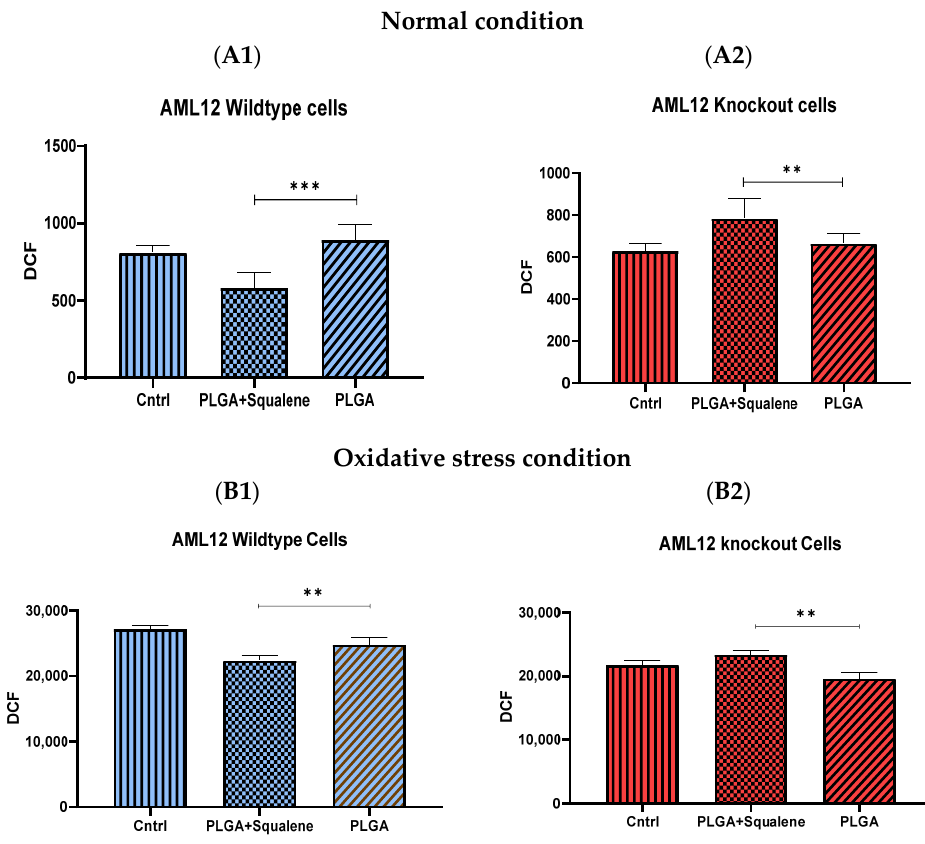
Figure 4. Assessment of ROS production in normal mouse AML12 cells cell line (AML12 wild-type (WT)) and TXNDC5-deficient AML12 cells (AML12 knockout (KO)). ( A , B ) After treatment of cells with 30 µ M of squalene NPs for 72 h, ( A ) ROS was measured in normal conditions, ( B ) oxidative stress circumstance by 25 mM of H 2 O 2 for 3 h. ( A1 ) potent reduction of ROS in squalene group in WT cells, and ( A2 ) significant enhancement in KO cells were observed. ( B1 ) Considerable decrement of ROS in squalene group in WT cells and ( B2 ) remarkable increase in KO cells are indicated. Statistical analyses were done according to Mann–Whitney’s U-test; ** p < 0.01, *** p < 0.001. The cell viability of WT and KO cells is shown in Figure 5. After 72 h exposure to 30 µ M concentrations of both mixtures of PLGA and of the squalene loaded into the PLGA nanoparticles, the cells were treated with three different concentrations of H 2 O 2 for 30